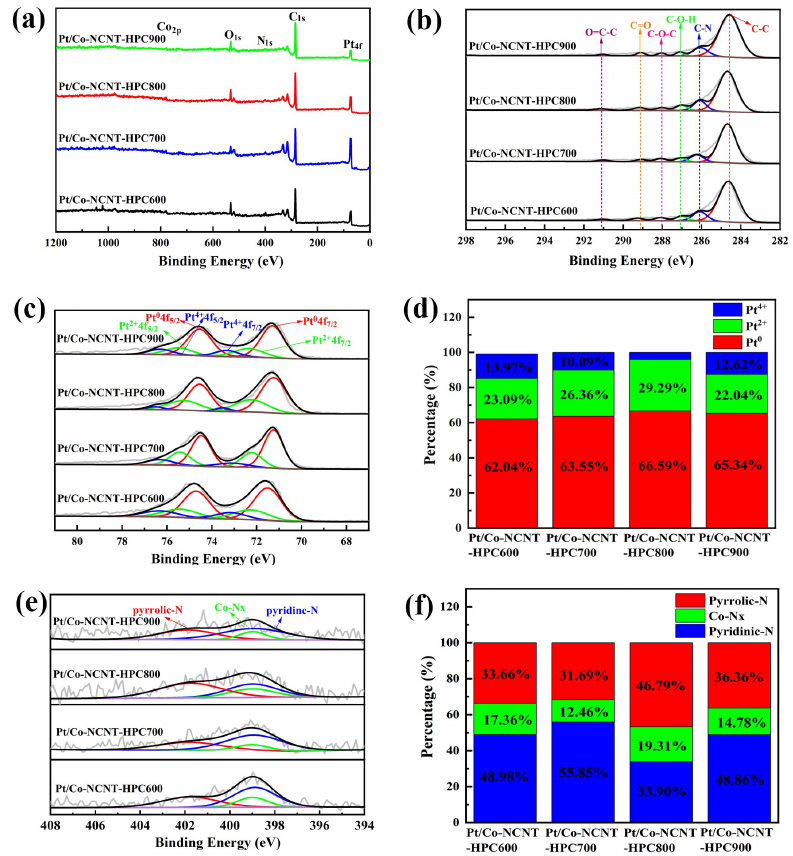
Figure 7. XPS spectra of ( a ) survey spectra; ( b ) C 1s spectra; ( c ) Pt 4f spectra; ( d ) Pt content; ( e ) N 1s spectra; and ( f ) N content of Pt/Co-NCNT-HPC catalysts.